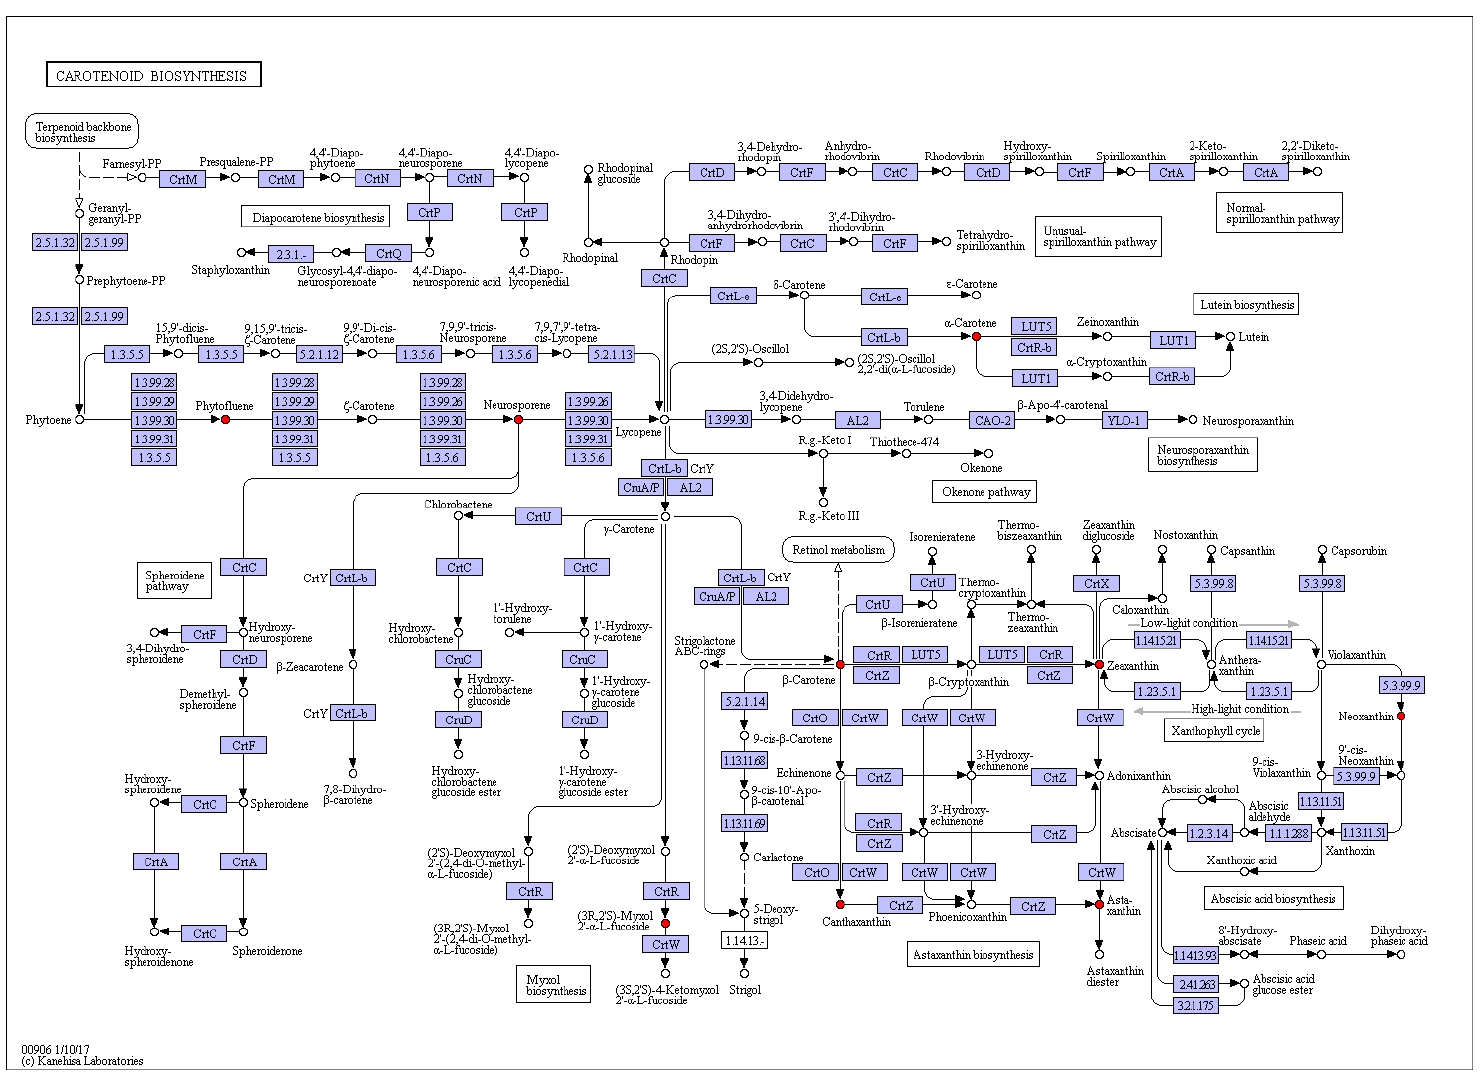
Figure A3. Carotenoid produced by Asaia lannensis and Asaia bogorensis strains tested in conducted study. Carotenoids are marked in red.